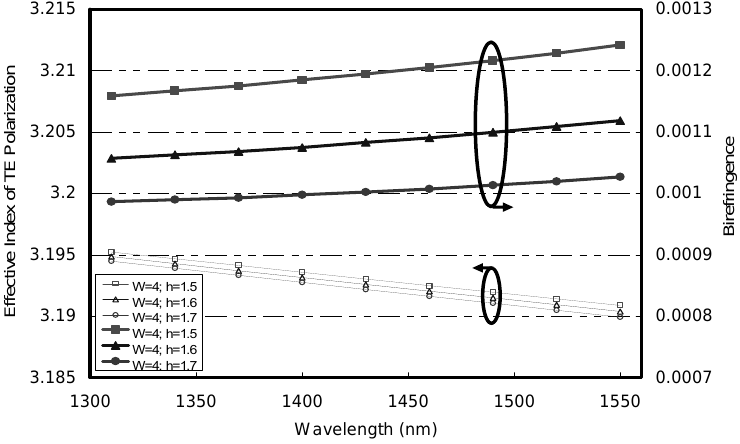
Figure 7. Birefringence as a function of wavelengths for AlGaAs/GaAs optical waveguides with the same width (W) of 4 µm for different etch depths (h) of 1.5 µm, 1.6 µm, and 1.7 µm [21].